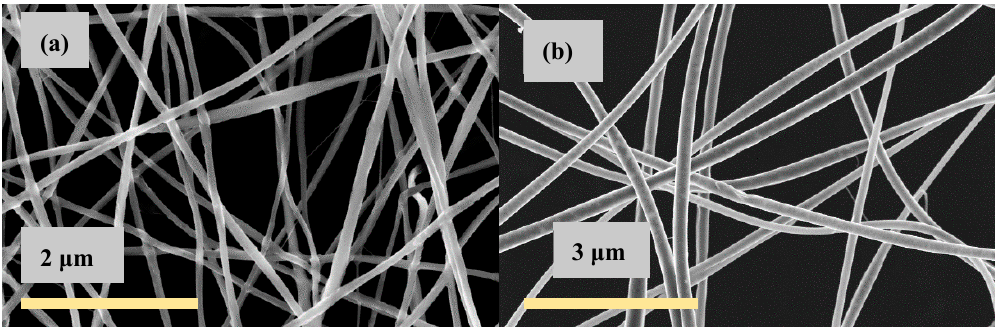
Figure 1. As-spun porous fiber mats produced from ( a ) 80/20 5% CS/PEO solutions, PEO MW = 1000 kg/mol and ( b ) 95/5 5% CS/PEO solutions. CS MW = 160 kg/mol and PEO MW = 5000 kg/mol [53].